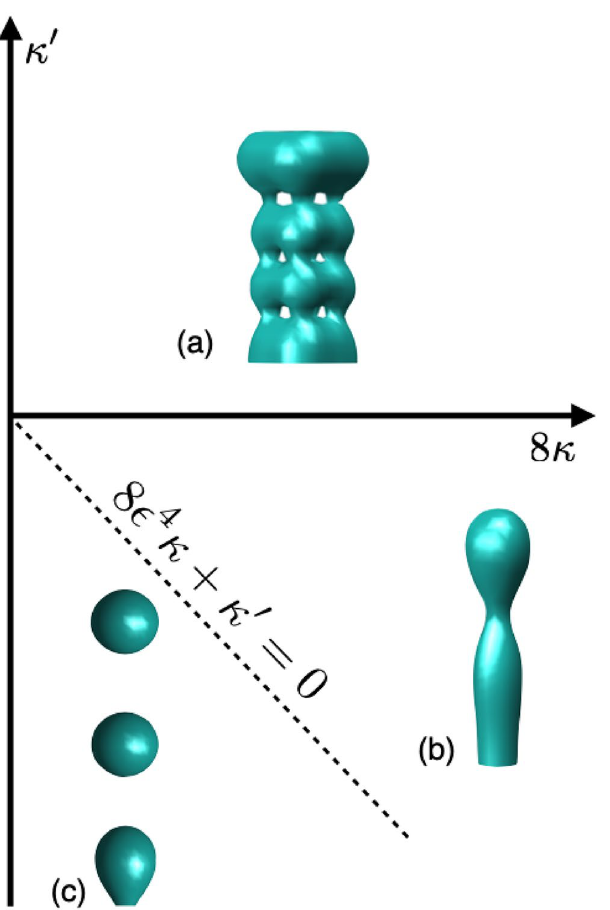
1 . ( a ) Multiple self-connected membrane = 8 κ , and ( c ) vesicle formation with a magnitude of −